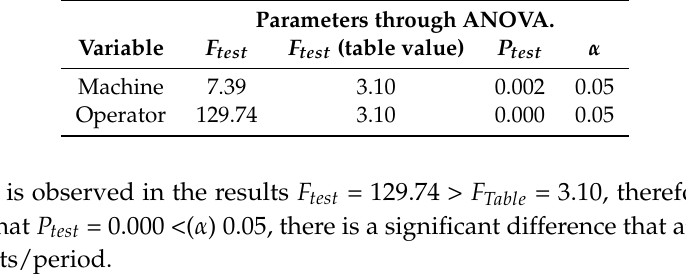
Table 9. Results of ANOVA analysis for the machine and operator variables. Parameters through ANOVA.